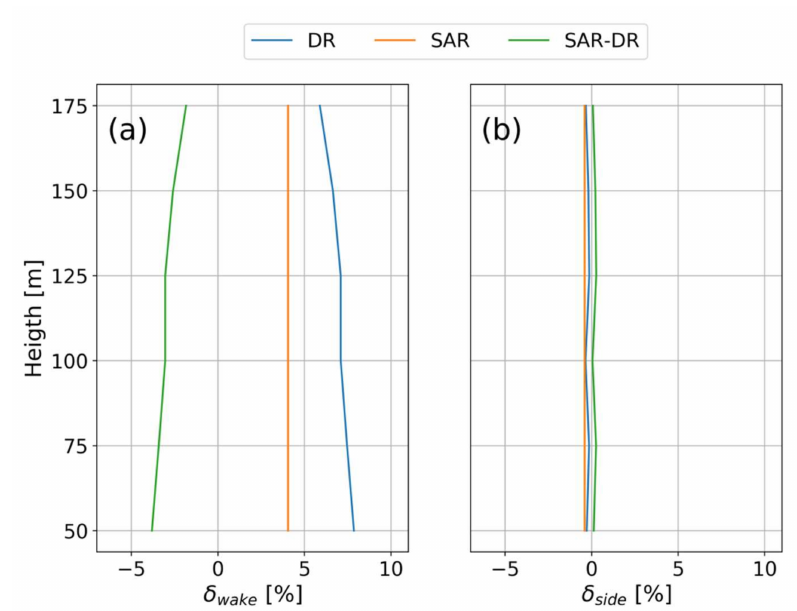
Figure 14. Comparison of velocity deficits ( δ ) from SAR, Dual-Doppler radar (DR), and their di ff erence for ( a ) upstream and wake and ( b ) upstream and